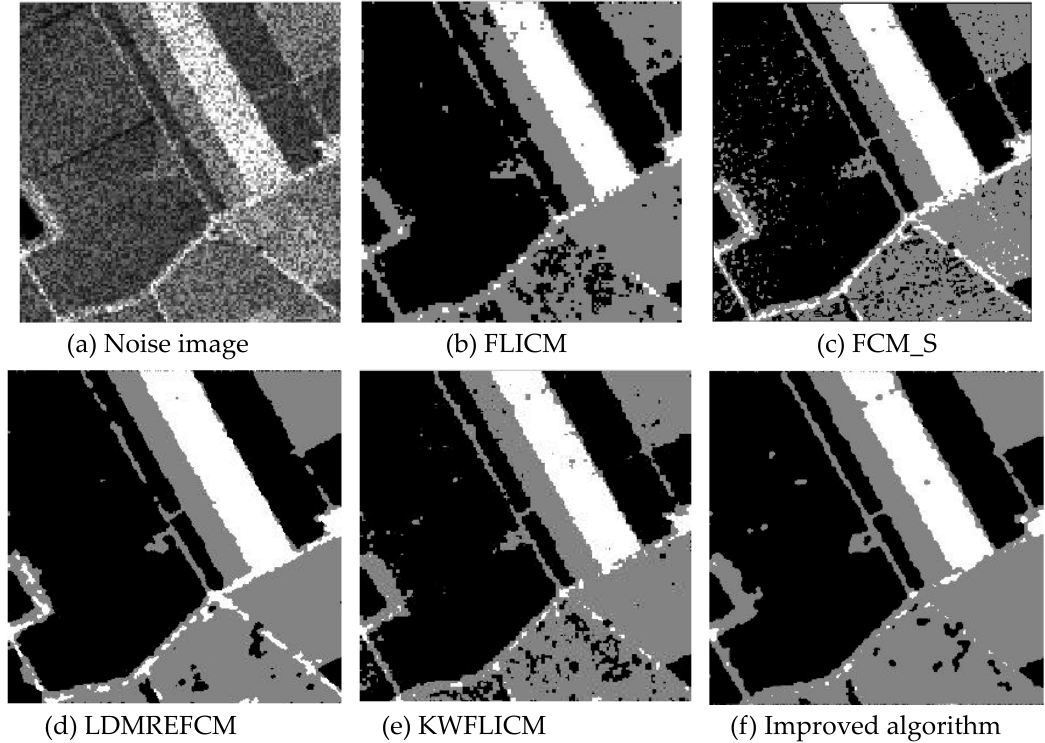
Figure 10. Multiplicative noise disturbing remote sensing image 1 ( a ) and the segmentation results ( b – f ).